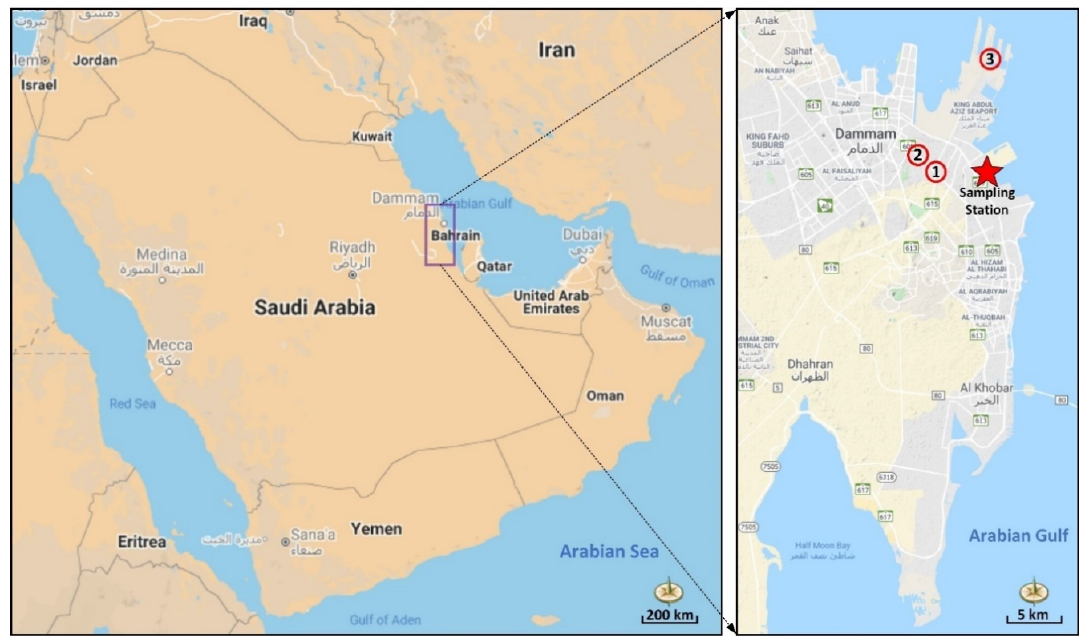
Figure 1. Location of the monitoring station and potential emission locations: (1) intersection of King Abdulaziz and King Fahd roads, (2) Industrial Area #1, and (3) King Abdulaziz Sea Port.